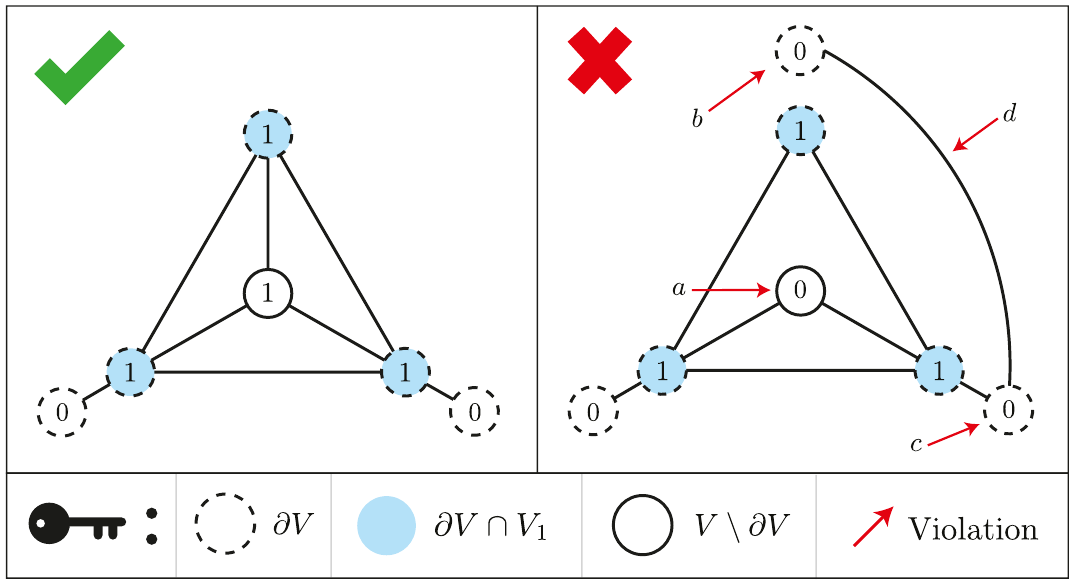
Figure 3. (Left) a planar graph with dangling edges. (Right) a graph which does not meet the requirements for a planar graph with dangling edges because of the following issues: a) there is a node in V which is not in ∂V , b) there is a node in V 0 c) there is a node in V which participates in more than one edge, and d) there is an edge connecting 0 two nodes in V 0